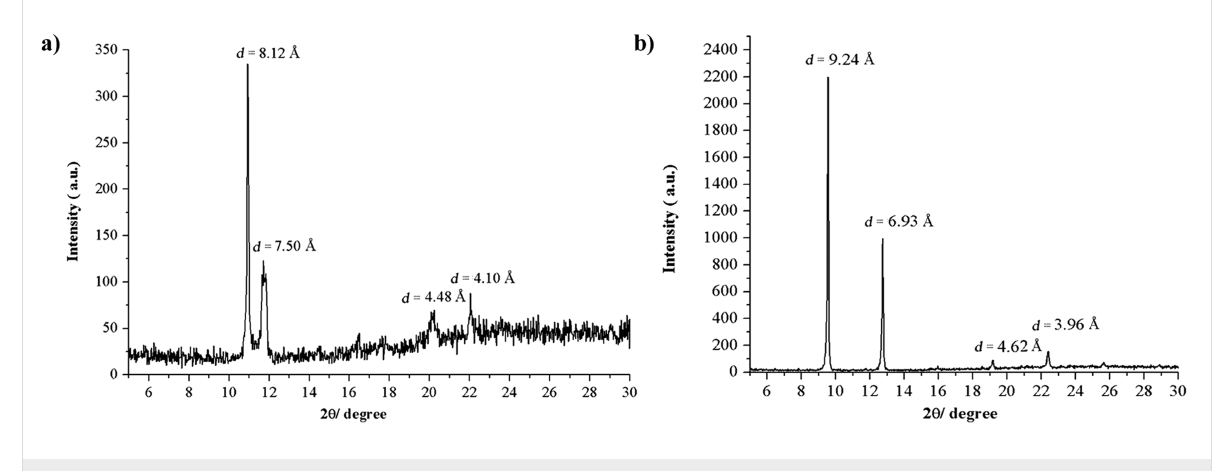
Figure 7: Powder X-ray diffraction patterns of xerogel of (a) TPM-G12 from propan-1-ol and (b) TPM-G5 from DMSO.